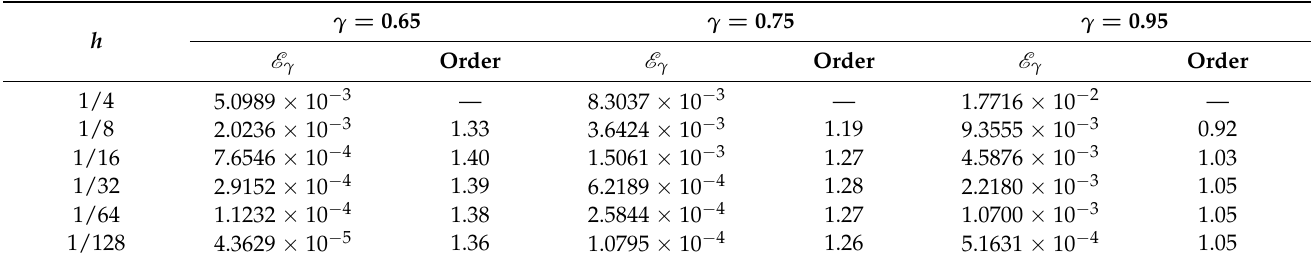
Table 3. E γ and numerical convergence order in the spatial direction ( k = 1.25 × 10 − 6 ).